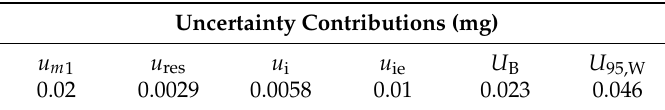
Table 3. The uncertainty contributions for the weight measurements on the precision